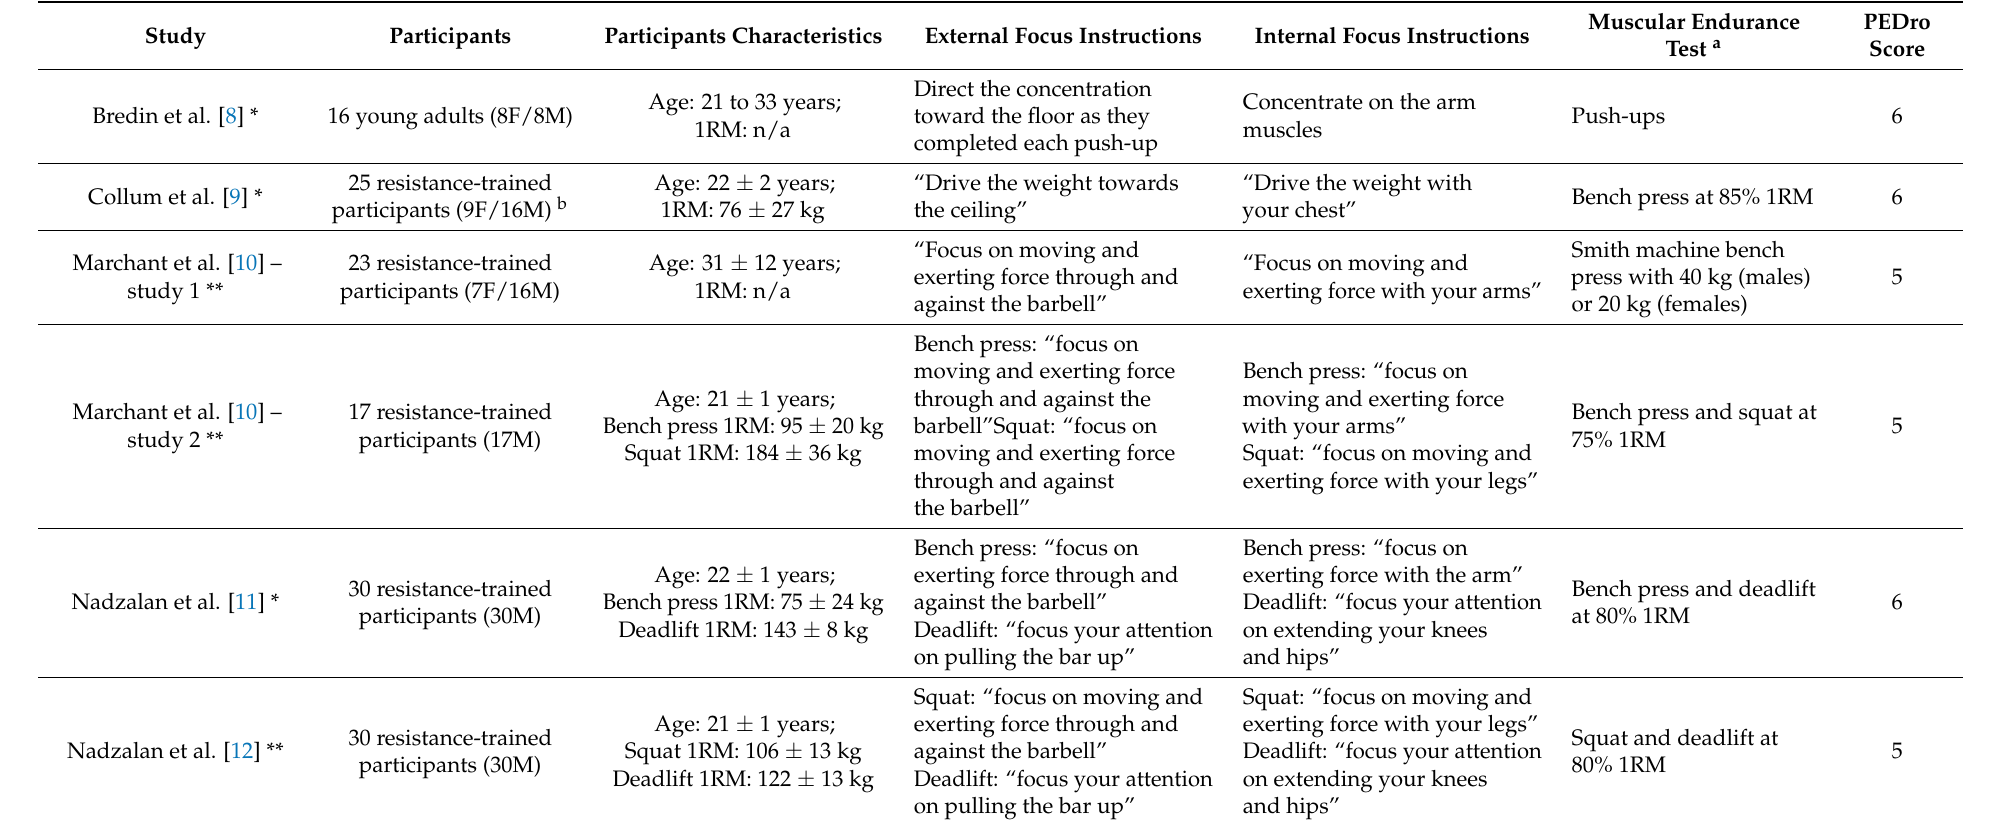
Table 1. Summary of the studies included in the review. All studies explored the acute effects of attentional focus on muscular